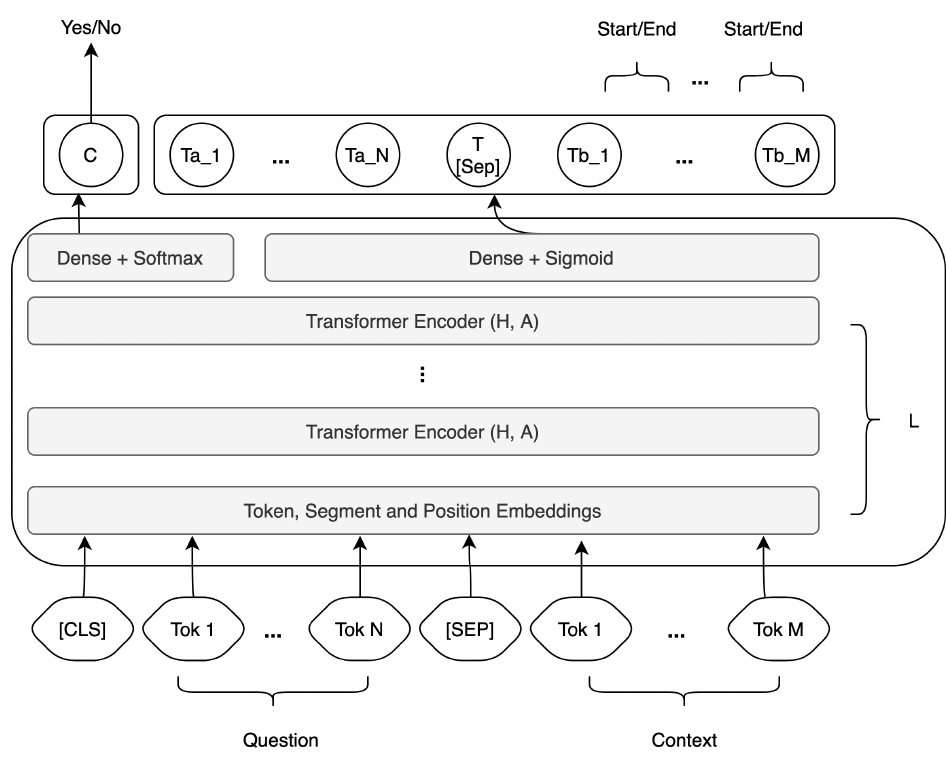
Figure 2. Extractor model